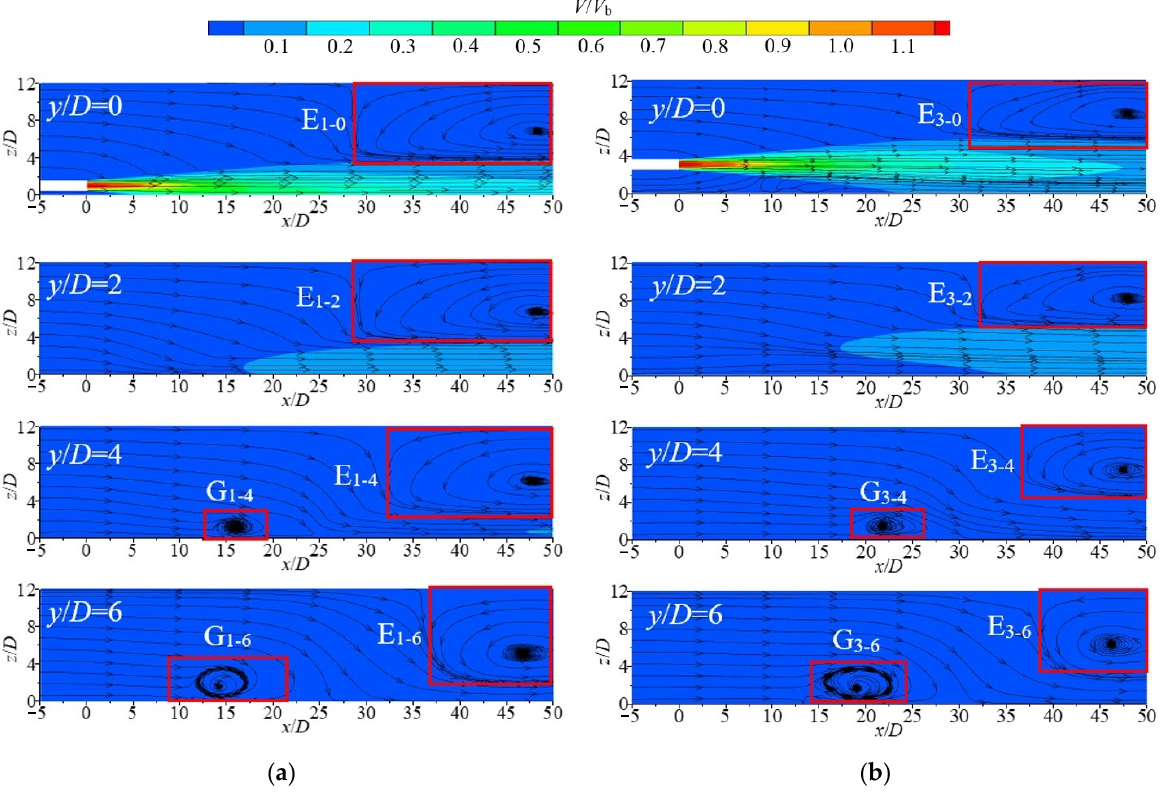
Figure 8. Contours with streamline diagrams of V / V b distribution for different shot vertical sections: ( a ) H / D = 1; ( b ) H / D = 3.